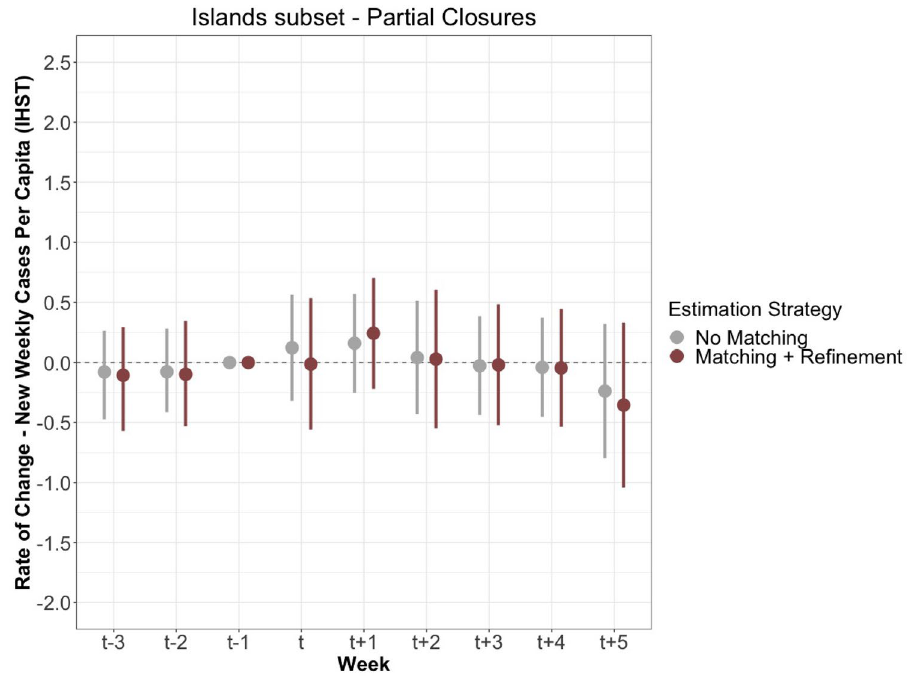
Figure 6. The measured effects of partial closure on the rate of change of new cases per capita after IHST (y-axis) for a sub-set of 89 island nations. The estimates are shown with both no matching or refinement in grey, and matching and refinement in red, calculated with 95% confidence intervals. The period includes nine weeks: three prior to the lockdown, the week of the lockdown, and five following the